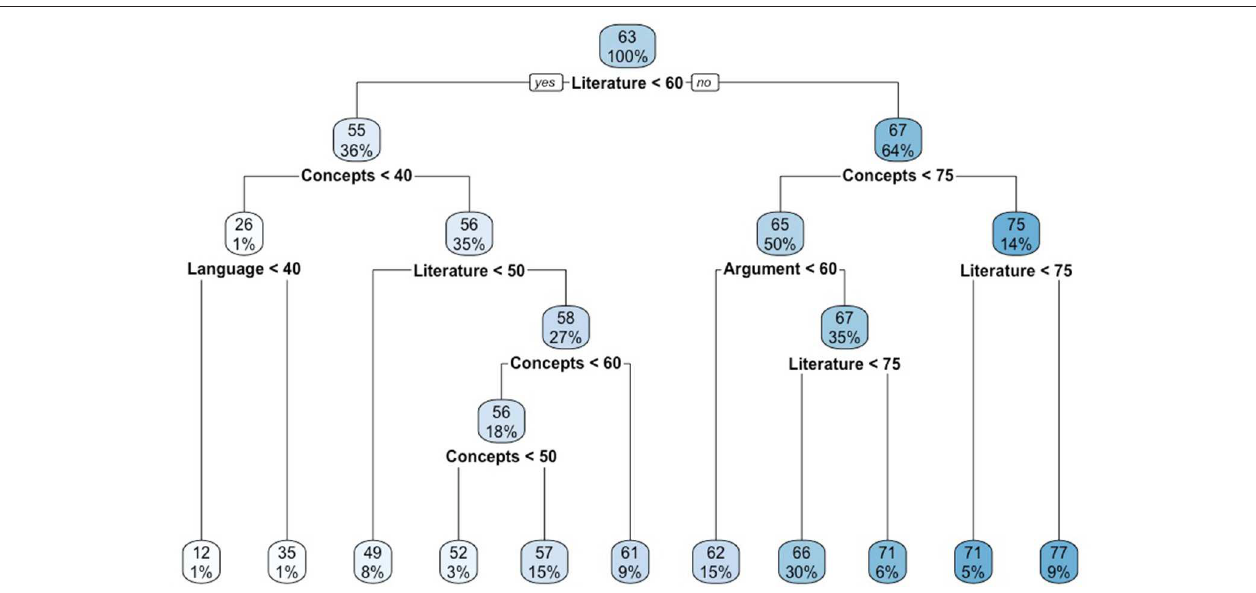
FIGURE 5 | Simplified decision tree for year 3 exams, pruned after 10 splits for illustrative purposes. The top number in each node is the percentage mark prediction at that point in the tree, and the bottom number is the percentage of the sample contained within that node. Literature: Relevance and range of the literature; Concepts: Descriptions and explanations of concepts and relation between them; Argument: Development of the argument; Language: Use of scientific language and style.